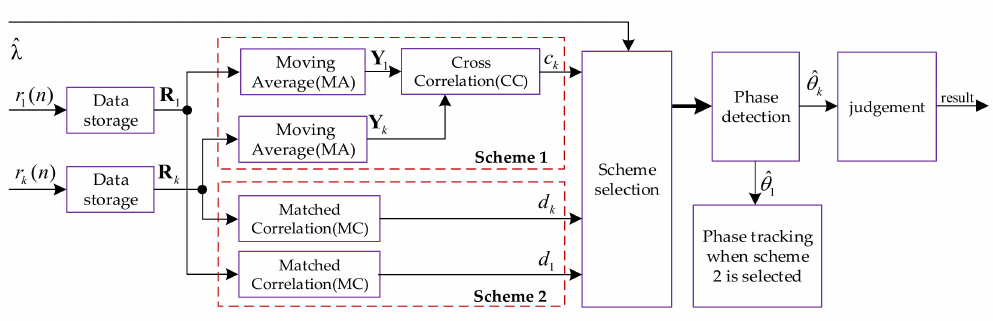
Figure 3. Flow diagram of the PPM demodulation method employed in this